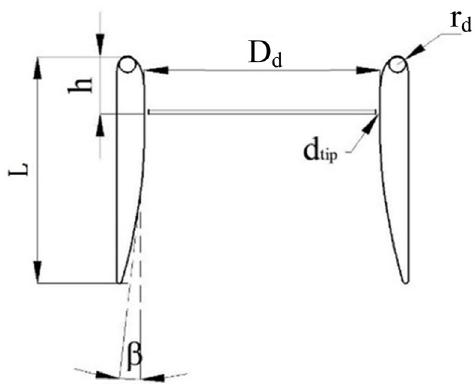
Figure 8. The geometric parameters of the duct wall cross-section.